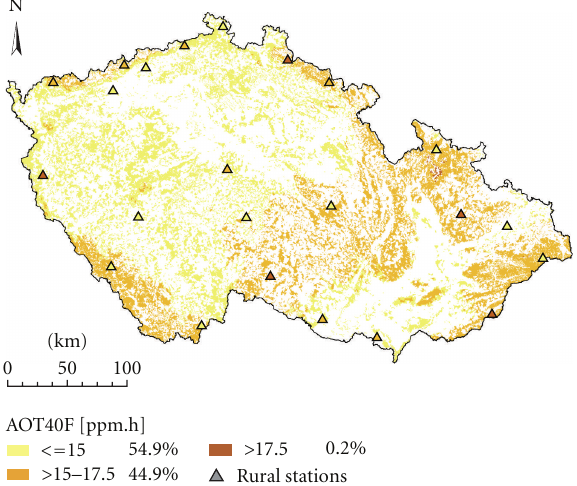
Figure 4: Spatial interpolation of exposure index AOT40F for the 2008 vegetation season (ppb.h), interpolation technique LR + res OK, grid resolution 1 × 1 km, forested areas.